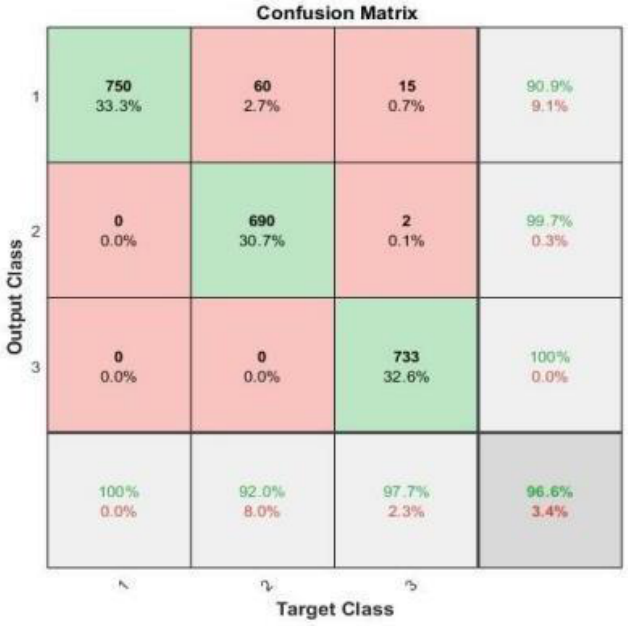
Figure 5. Confusion matrix for the proposed